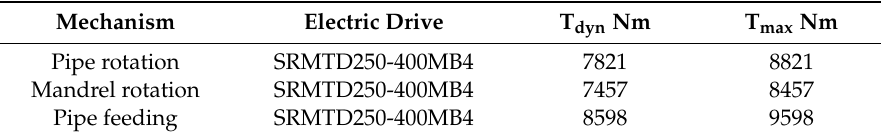
Table 1. Dynamic and total loads of the HPT-250